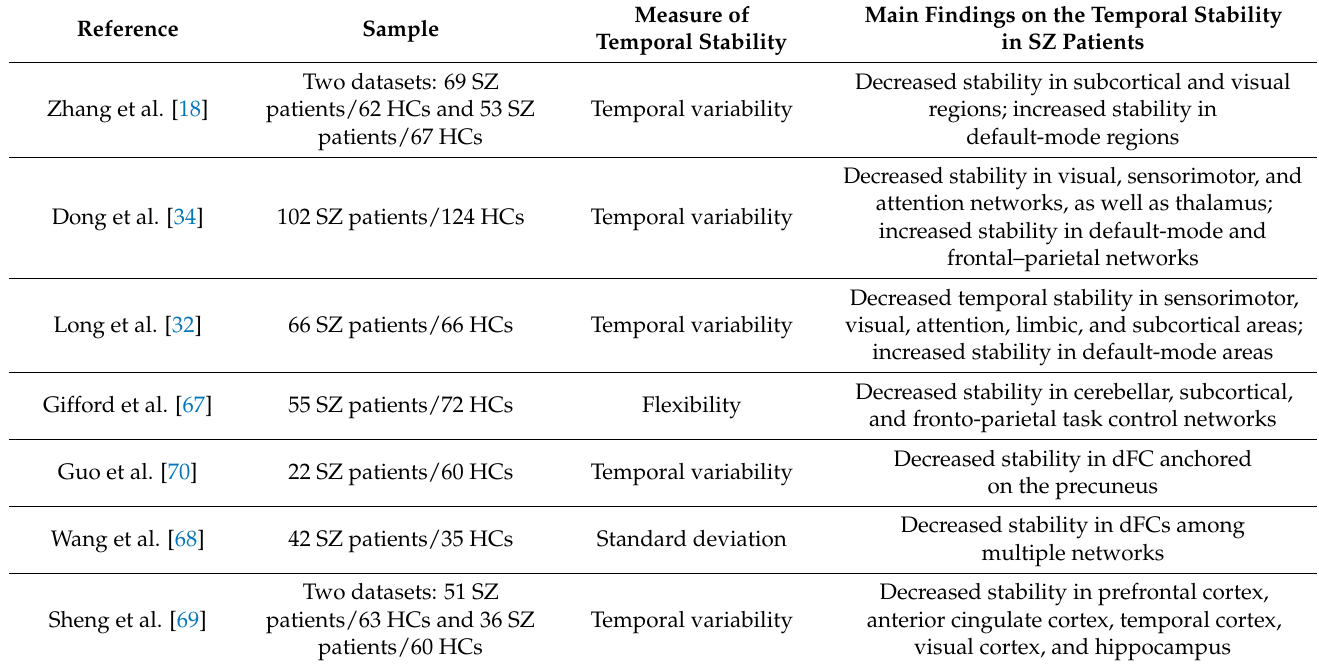
Table 1. Summary of main findings of changes in the temporal stability of brain network in patients with schizophrenia (SZ) as mentioned in this manuscript. dFC, dynamic functional connectivity; HCs, healthy